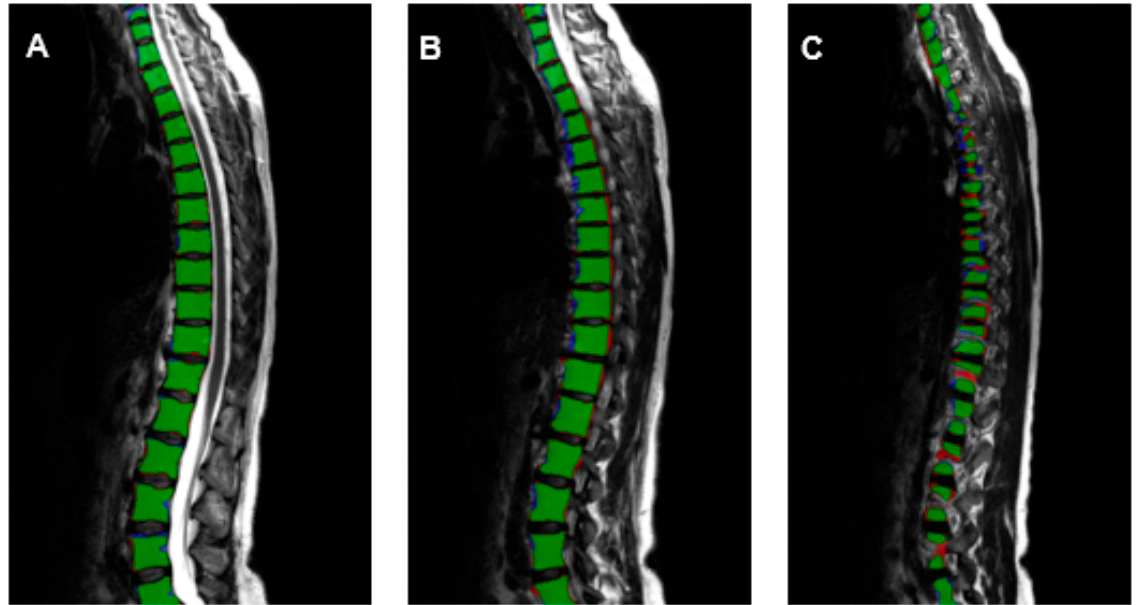
Figure 4. T2-weighted sagittal images ( A )—medial, ( B )—mediolateral, ( C )—lateral of the entire spine with the evaluation of the AI-based vertebral body segmentation in comparison to the seg- mentation of the radiologists (green—true positive, blue—false negative, red—false positive).